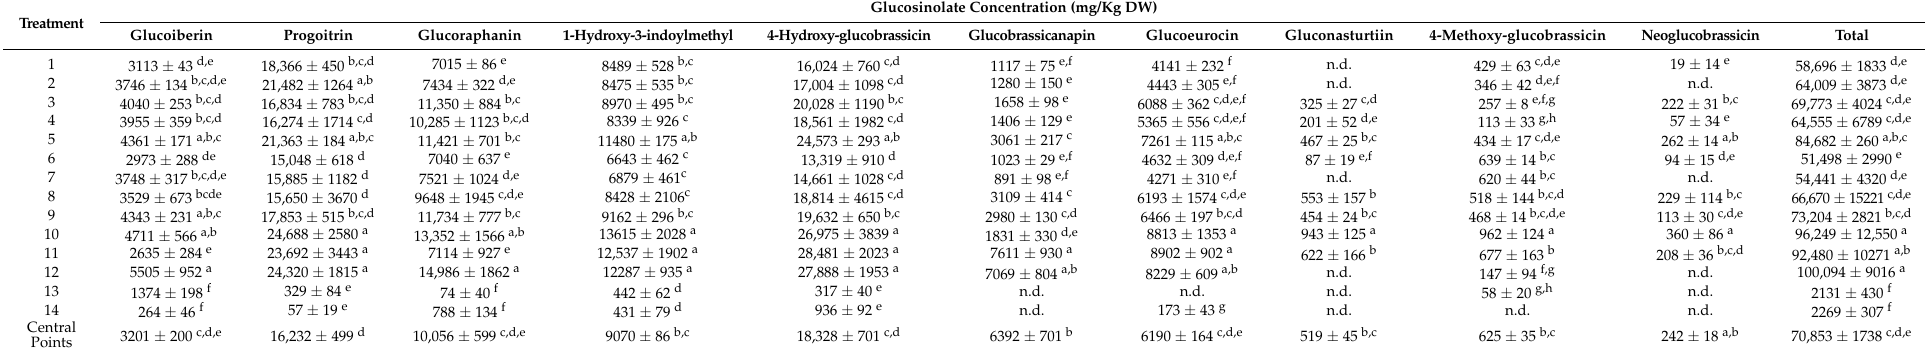
Values represent the means of 3 replicates ± standard error. Values with different superscript letters in the same column indicate a statistical difference between the mean concentration of the bioactive compound in the morphotypes evaluated using the LSD test ( p <